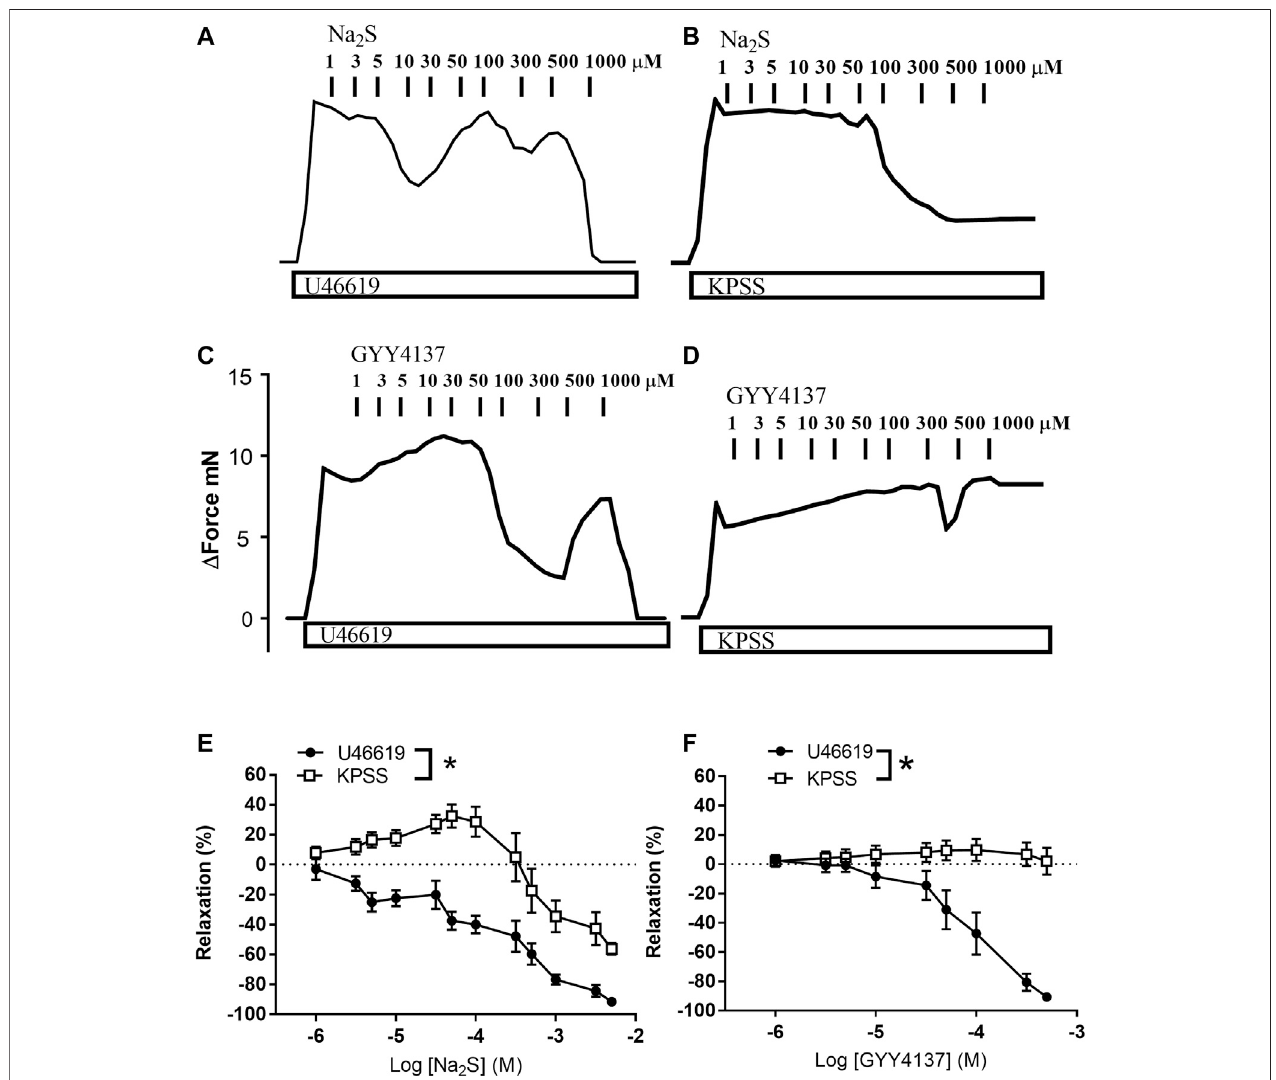
FIGURE 7 | Effect of high extracellular potassium (KPSS) on Na 2 S and GYY4137 relaxation. Original traces showing contractions induced by 3 µM U46619 or 60 mM KPSS and effect of increasing concentrations of (A,B) Na 2 S (1 – 1,000 µM) or (C,D) GYY4137 (1 – 1,000 µM). (E) Average Na 2 S induced vascular relaxations in vessels contracted with U46619 or KPSS; (F) Average GYY4137 induced vascular relaxations in vessels contracted with U46619 or KPSS. Where no error bars are indicated, error lies within dimensions of symbol. All data are means ± SEM ( n (cid:2) 5 – 10). * p < 0.05, two-way ANOVA.